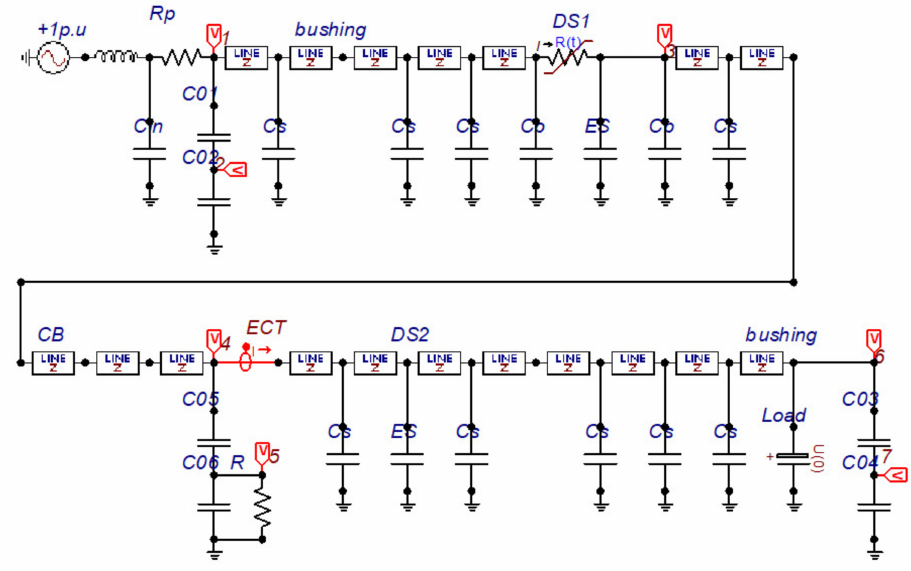
Figure 2. Model of the very fast transient current (VFTC) simulation